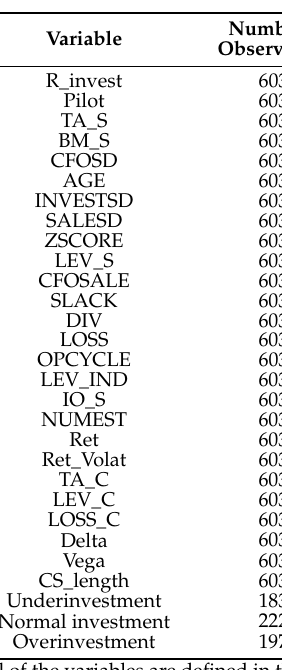
Table 2. Summary